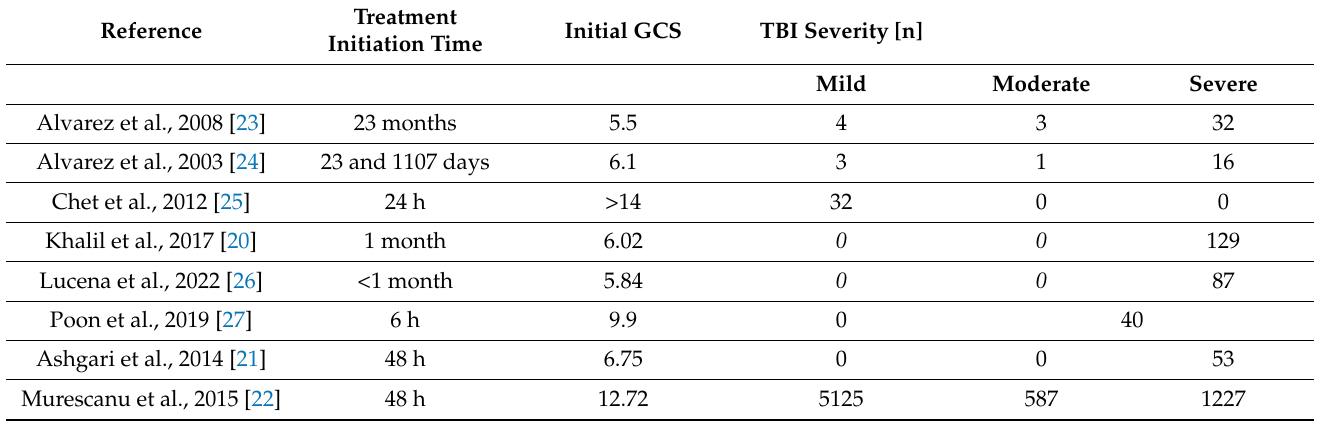
Table 4. Treatment initiation time, initial GCS, TBI severity in Cerebrolysin and control